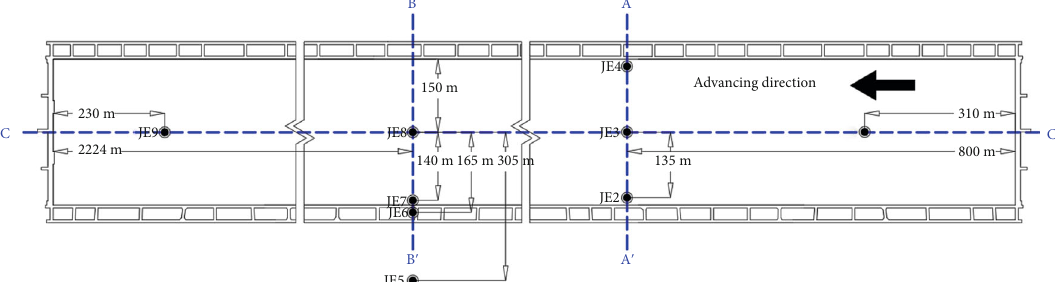
Figure 3: Boreholes layout at No. 101 working